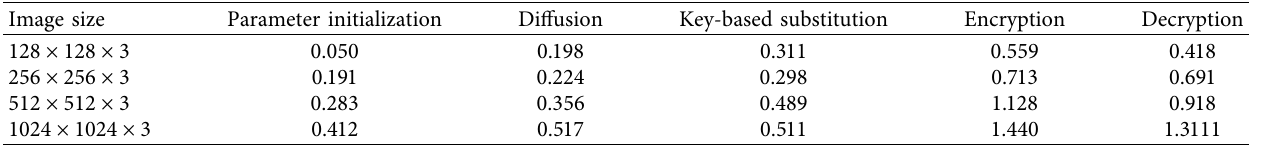
Figure 8: Data loss and noise attacks on encrypted images. (a) The untouched encrypted image and (b) its decrypted image; (c) the encrypted image with 3 × 3 data block loss and (d) its decrypted image; (e) the encrypted image with 9 × 9 data block loss and (f) its decrypted image; (g) the encrypted image deteriorated with 0.005% Salt and Pepper noise and (h) its decrypted image; (i) the encrypted image deteriorated with 0.02% Salt and Pepper noise and (j) its decrypted image. Table 9: Time complexity analysis (in seconds) of offered